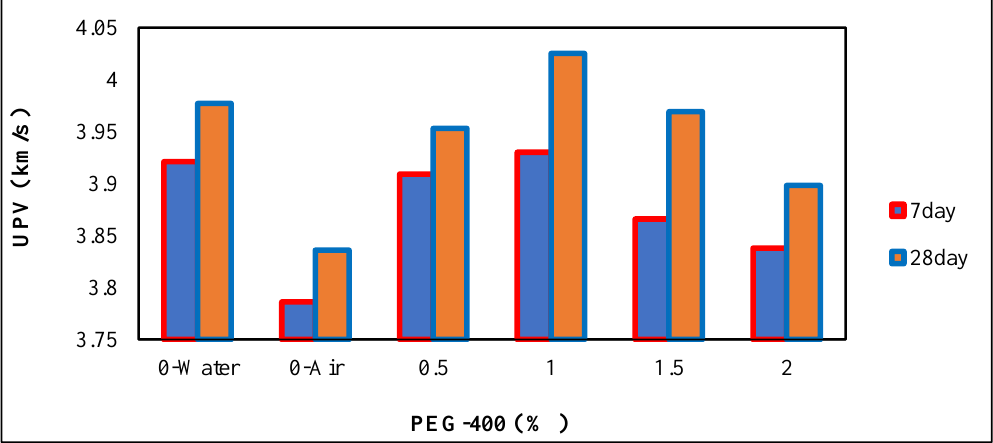
Figure 8. UPV values of concrete containing different PEG percentages.